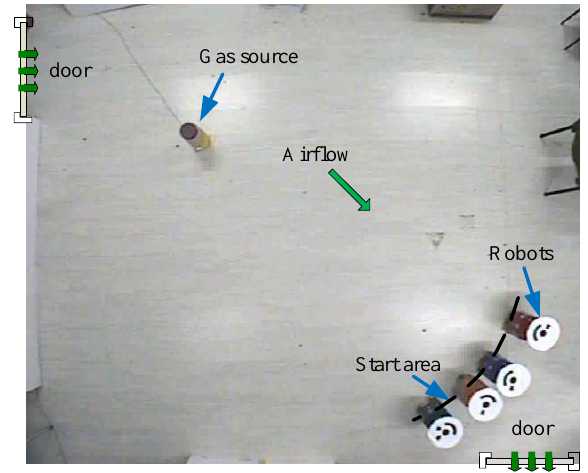
Figure 6. Arena I as seen from the overhead camera.